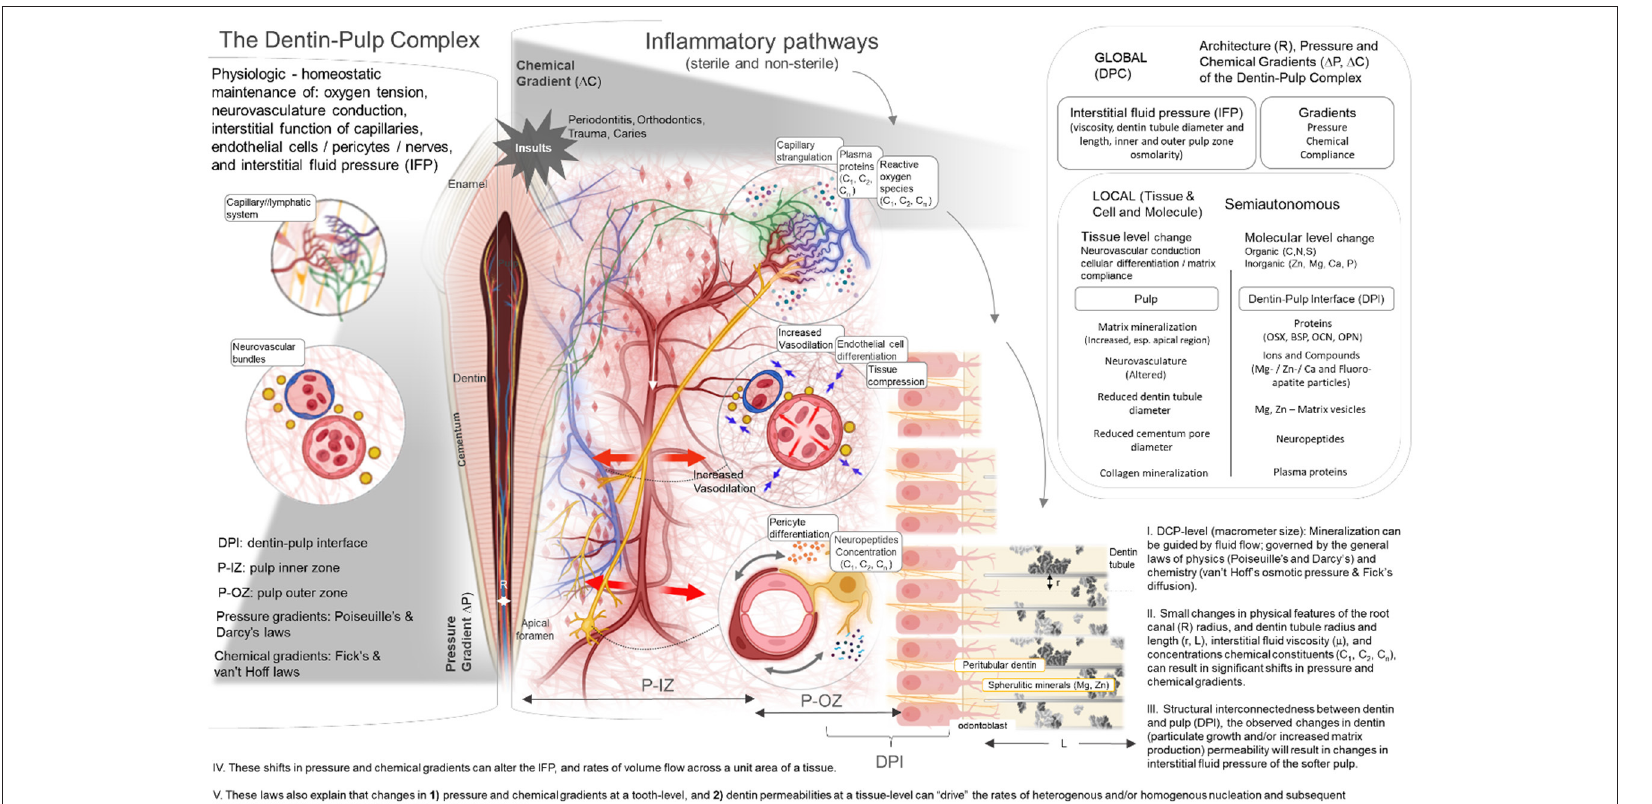
FIGURE 6 | Insights into Pulp Biomineralization Pathways: (I) DPC-level (macrometer size): Mineralization can be guided by fluid flow; governed by the general laws of physics (Poiseuille’s and Darcy’s) and chemistry (van’t Hoff’s osmotic pressure & Fick’s diffusion). (II) Small changes in physical features of the root canal (R) radius, and dentin tubule radius and length (r, L), interstitial fluid viscosity ( µ ), and concentrations chemical constituents (C 1 , C 2 , C n ), can result in significant shifts in pressure and chemical gradients. (III) Structural interconnectedness between dentin and pulp (DPI), the observed changes in dentin (particulate growth and/or increased matrix production) permeability will result in changes in interstitial fluid pressure of the softer pulp. (IV) These shifts in pressure and chemical gradients can alter the IFP, and rates of volume flow across a unit area of a tissue. (V) These laws also explain that changes in 1) pressure and chemical gradients at a tooth-level, and 2) dentin permeabilities at a tissue-level can “drive” the rates of heterogenous and/or homogenous nucleation and subsequent mineralization of an organic matrix even in the absence of